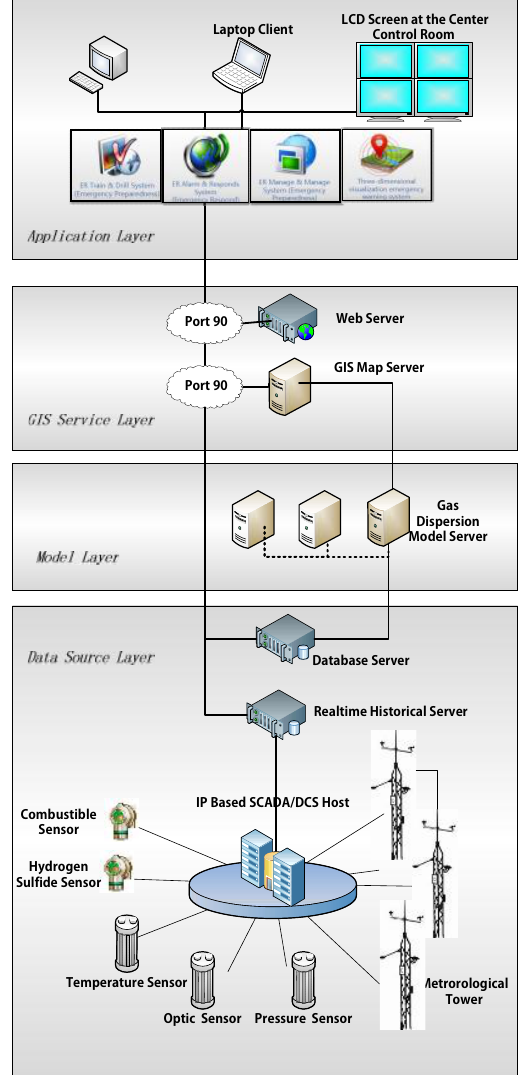
Figure 2. Emergency Response/Management System Computer